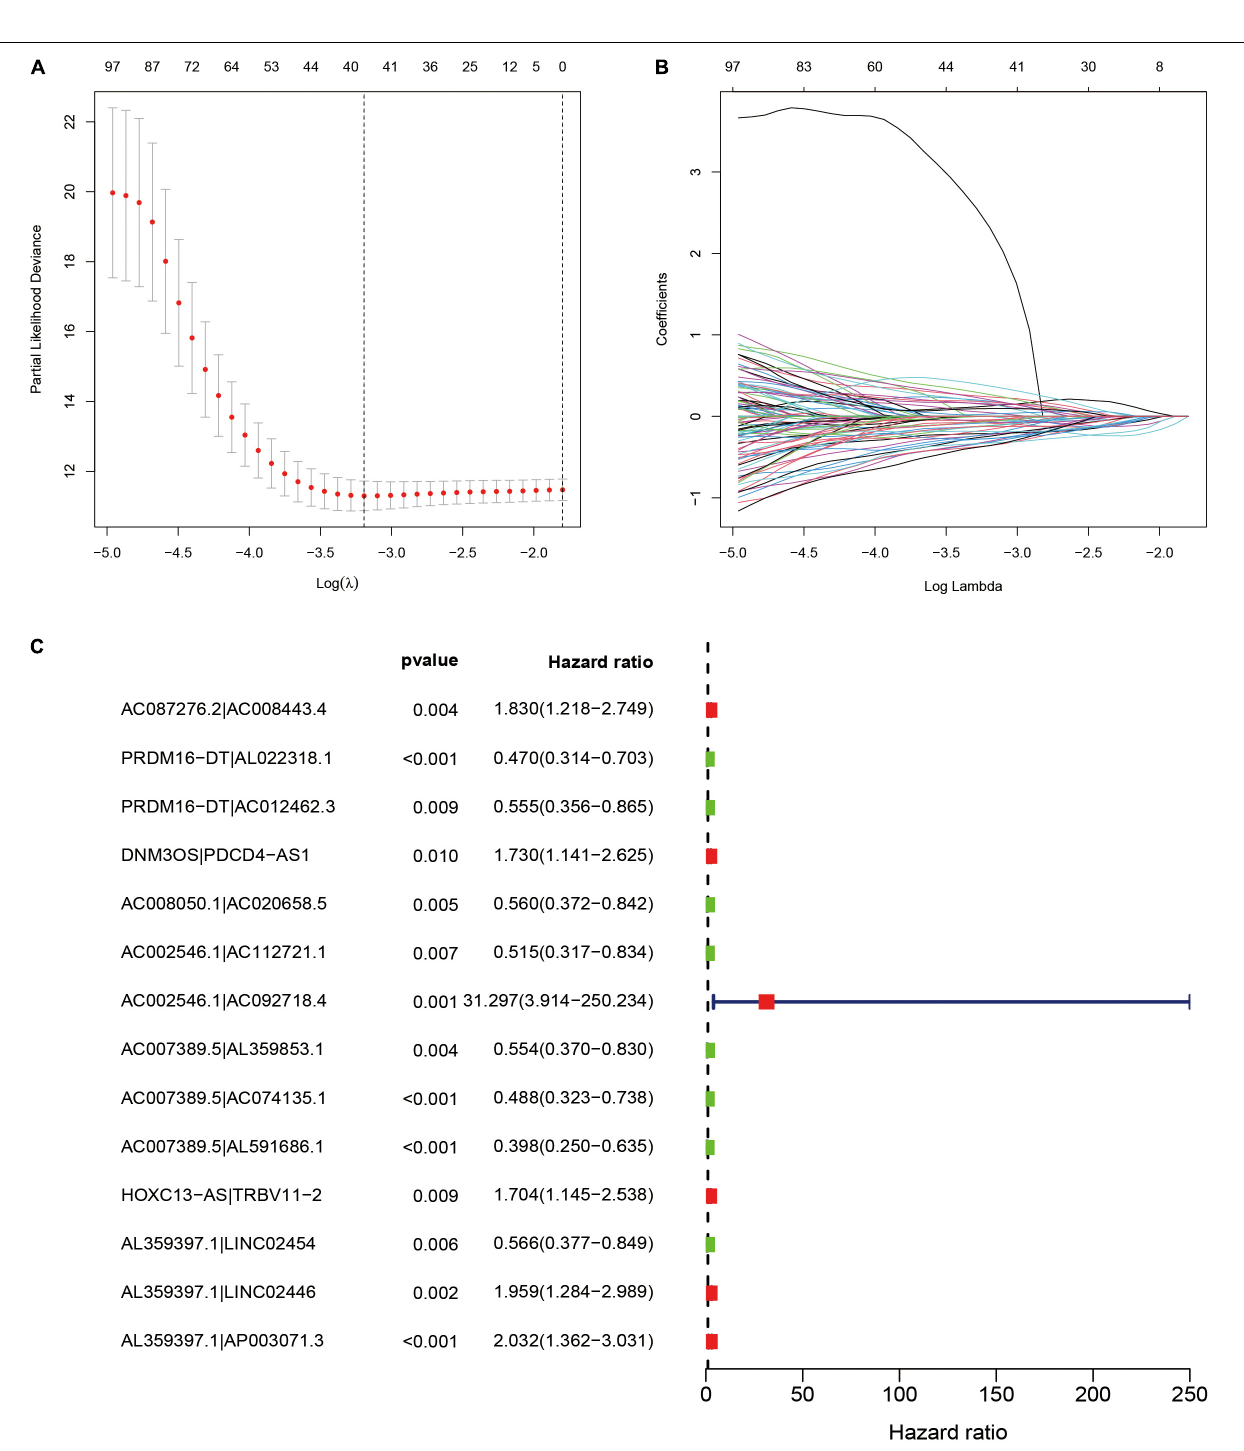
in cancer progression. For instance, LINC02454 was previously reported to be upregulated in papillary thyroid cancer, was closely related to various clinicopathological features, including large